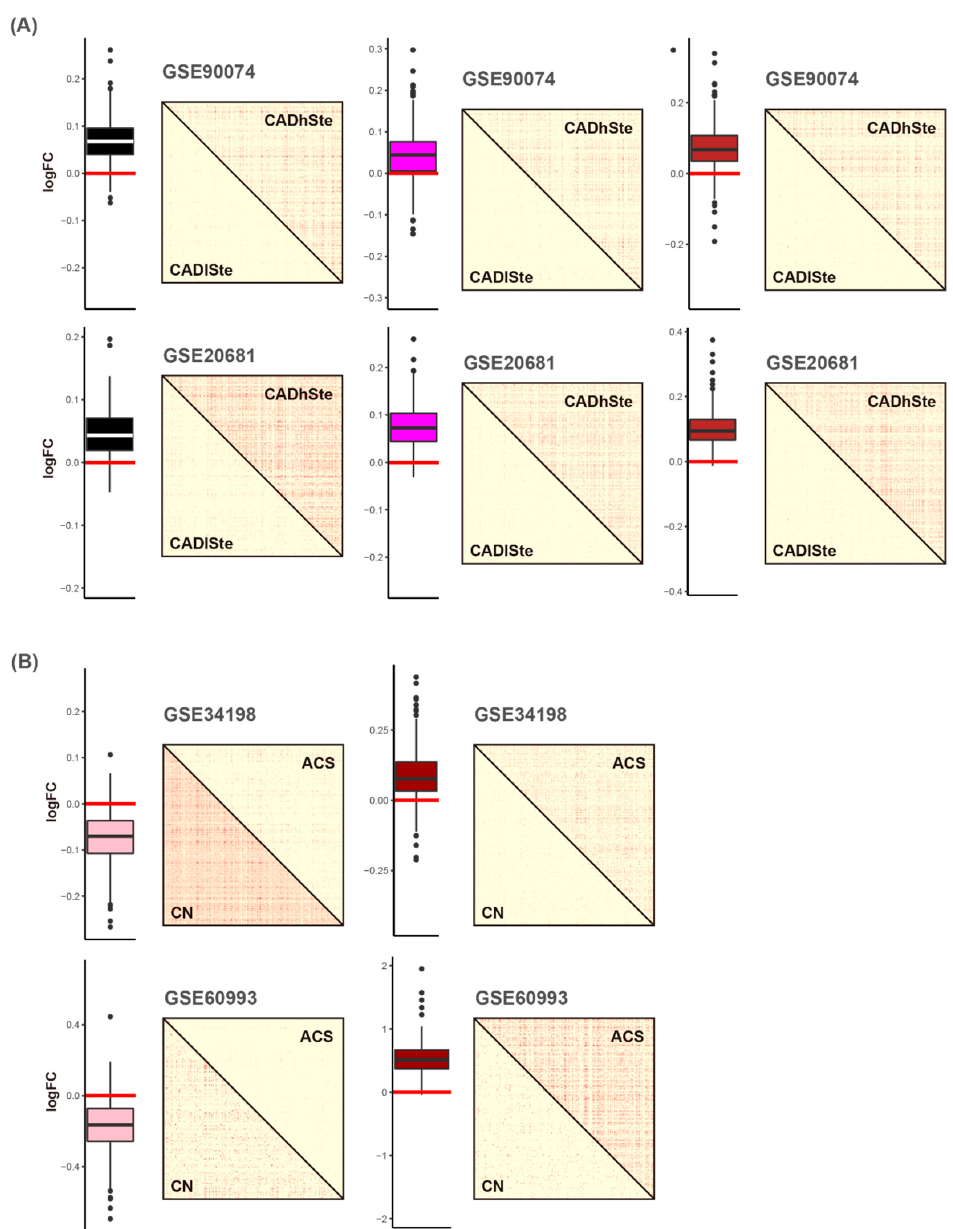
Figure 5. Selection of CAD obstruction ( A ) and ACS-related ( B ) modules based on differential co- expression analysis. Fold change (FC) values (logFC) between two conditions were calculated using the limma package. Adjacency matrices are described as six matrix plots. A matrix plot consists of two conditions: disease status including CAD obstruction and ACS is the upper triangular matrix, and matched control status is the lower triangular matrix. Abbreviations: FC, fold change; CAD, coronary artery disease; CADhSte, CAD with high stenosis; CADlSte, CAD with low stenosis; ACS, acute coronary syndrome; CN, matched control.